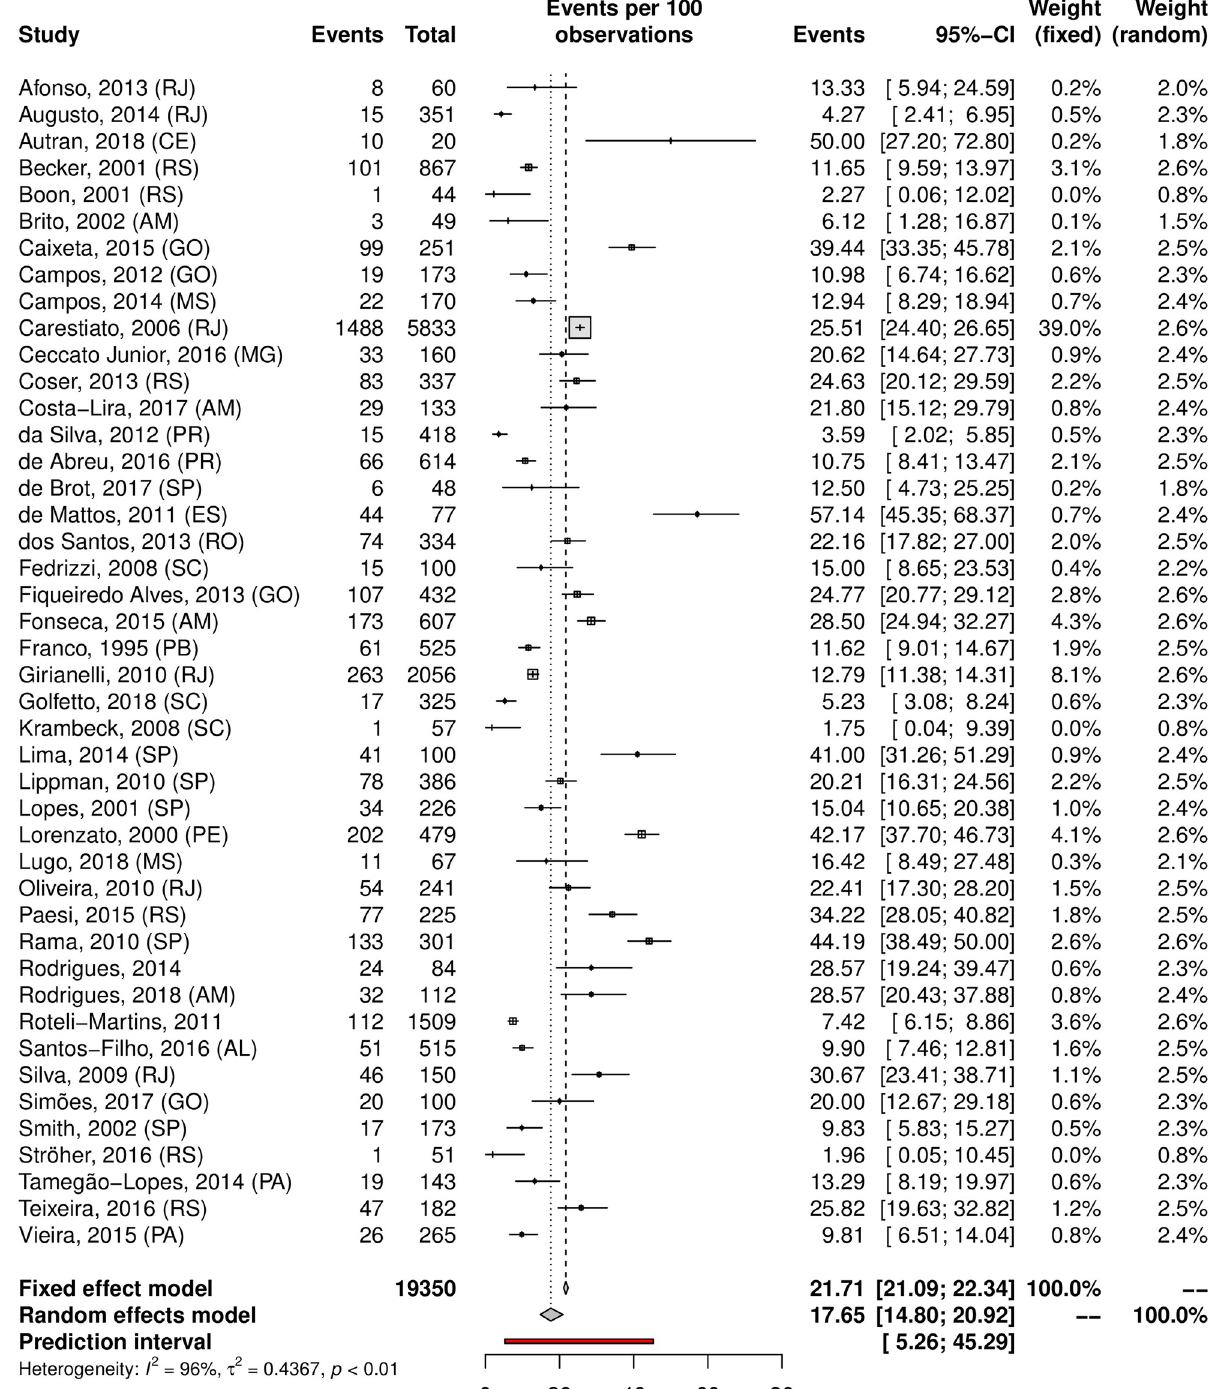
PLOS ONE | https://doi.org/10.1371/journal.pone.0229154 February 21,